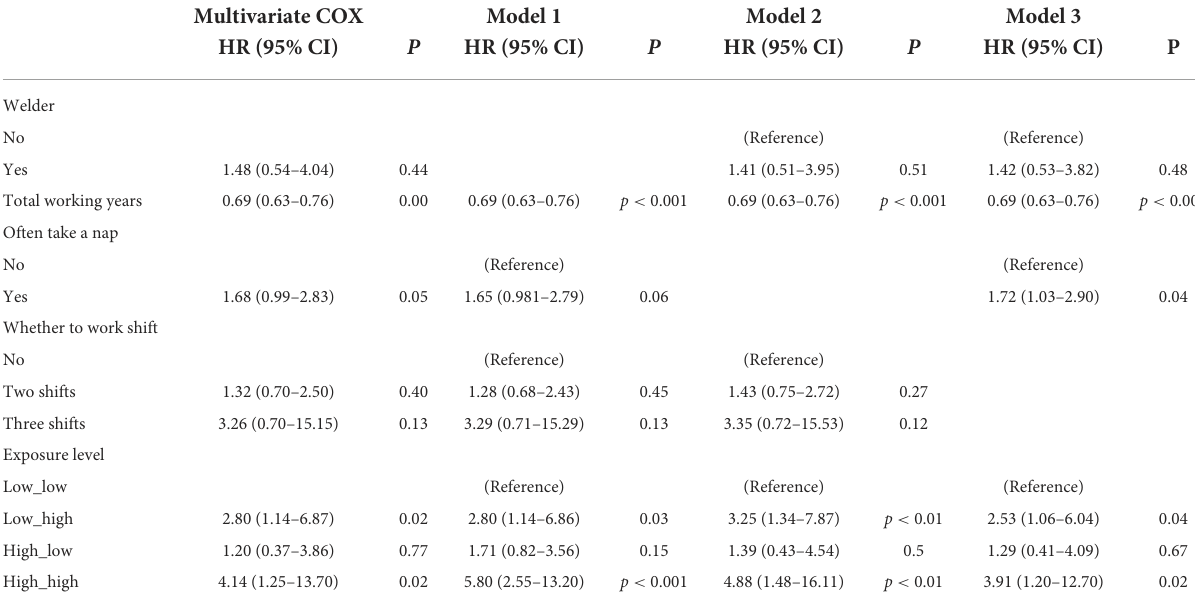
TABLE 3 Multivariate Cox model and sensitivity analysis model of influences lung-related